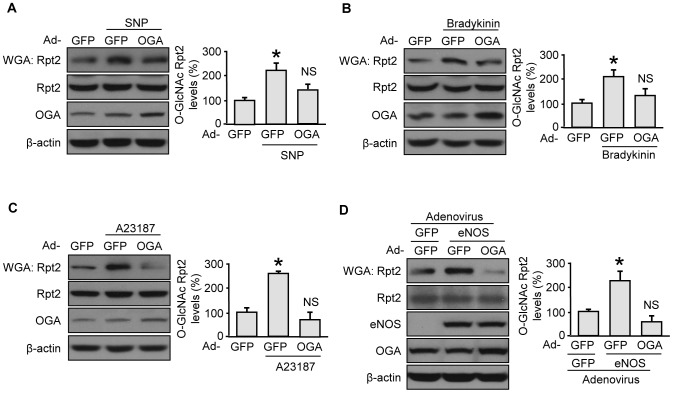
Upregulation of OGA reverses the NO-elevated O-GlcNAcylation of Rpt2.Adenoviral overexpression of OGA abolished Rpt2 O-GlcNAcylation induced by (A) SNP; (B) Bradykinin; (C) A23187; and (D) overexpression of eNOS. Rpt2 O-GlcNAcylation was detected with the WGA protocol. The shown blots were representative of at least 3 independent experiments with similar results. Ad-, Adenoviral overexpression; eNOS, endothelial nitric oxide synthase; NS, not significant (v.s. control); OGA, O-GlcNAcase; SNP, sodium nitroprusside; WGA, wheat germ agglutinin.